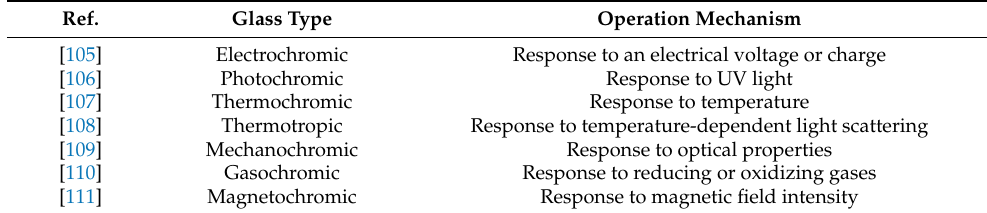
Table 2. Smart window types and their operation